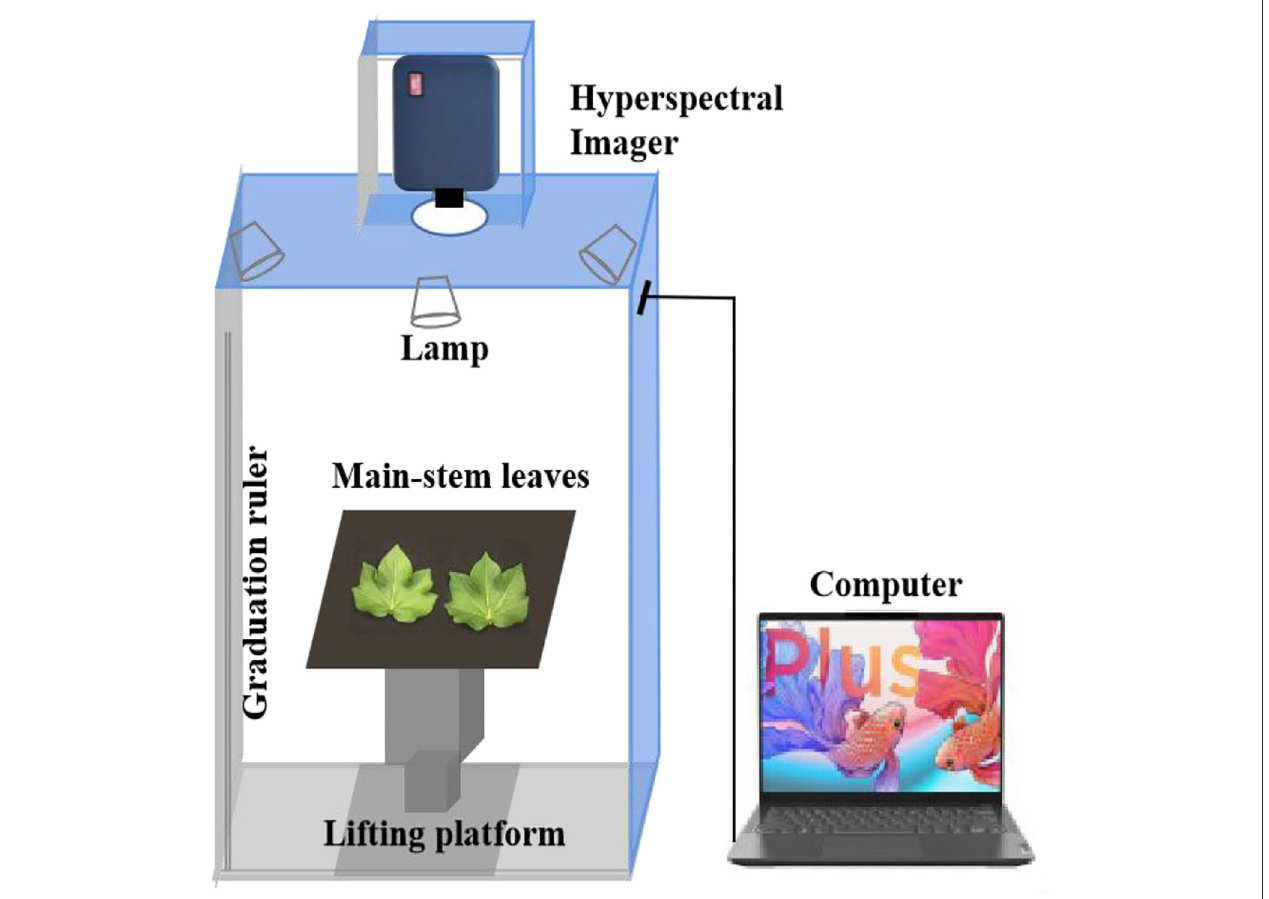
FIGURE 2 | Hyperspectral image acquisition system. System consisting of a hyperspectral imager, dark box, lighting system, lifting platform, and a computer.